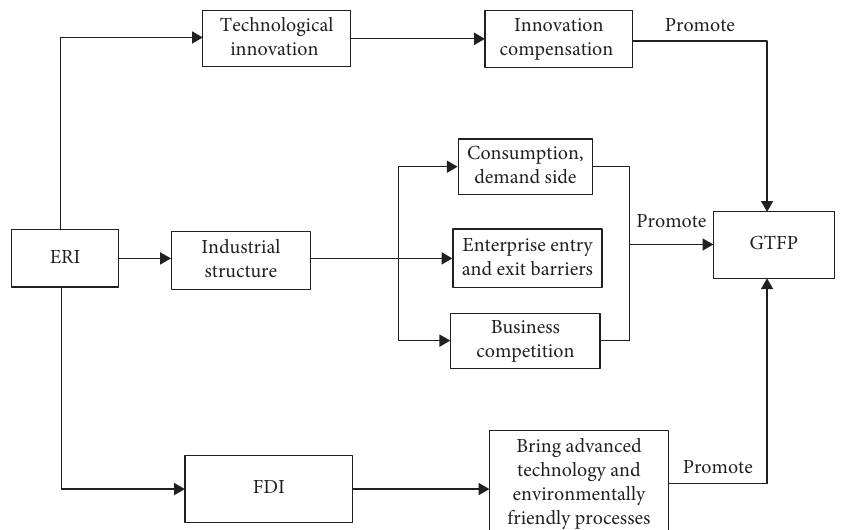
Figure 1: An analysis framework of the mechanism of ERI on GTFP of